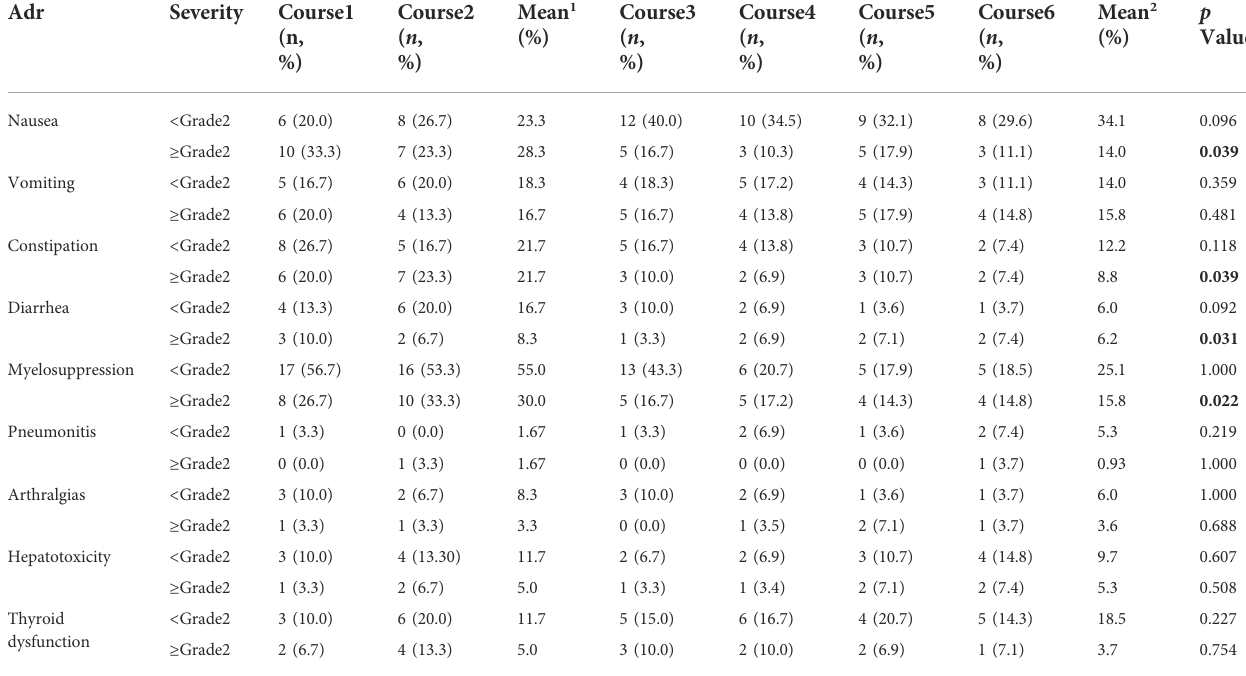
TABLE 3 The percentages of adverse events during each chemotherapy course.